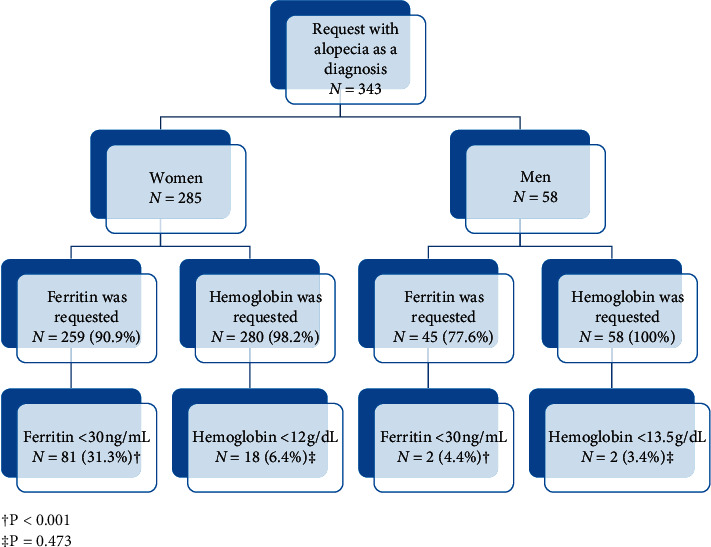
Results of the retrospective study legend: †P < 0.001 and ‡P=0.473.